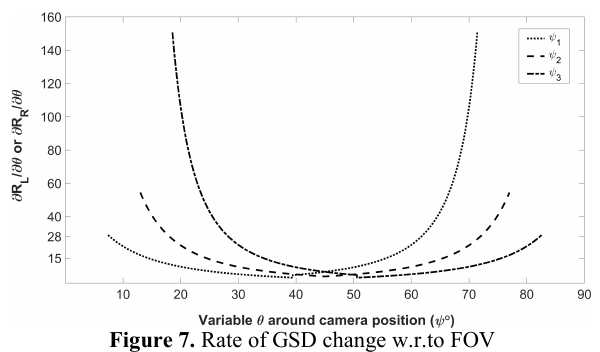
Figure 7. Rate of GSD change w.r.to FOV Rate of GSD change w.r.to FOV is of similar trend as that of the GSD variation (as shown in figure 6). The rate of GSD change for each of the three images is minimum and equal to zero at centre of the optical axis. However, from the left to right edges of the three images, the rates of GSD change vary in ranges of